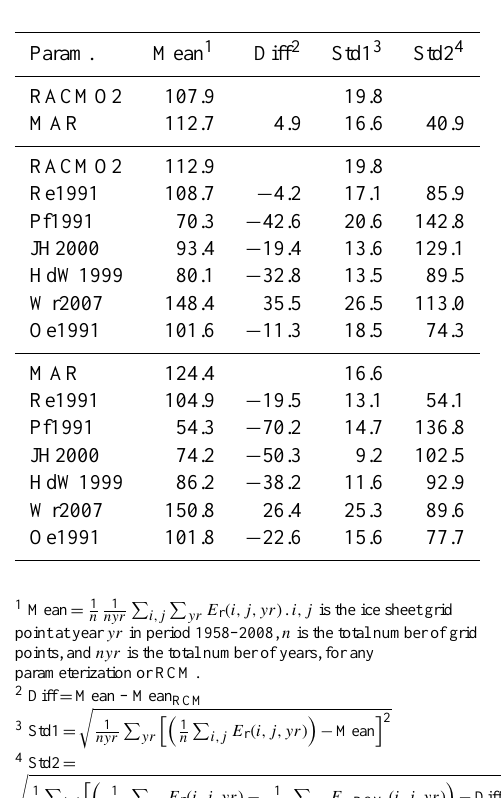
Table 2. Statistics of the different parameterizations compared to RACMO2 (second part) and MAR (third part). First part com- pares RACMO2 and MAR (MAR-RACMO2) for points where both models define ice. Mean 1 =ice sheet and period (1958–2008) aver- aged annual E r ; Diff 2 =difference of Mean with an RCM; Std1 3 =a measure for the temporal variability; Std2 4 =a measure for the spatial variability in the difference. All values are expressed in mmw.e.yr − 1